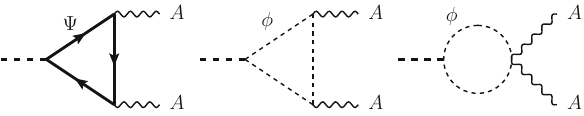
Fig. 2 One-loop diagrams contributing to the Wilson coefficients C AA and (cid:4) C AA in (1). We do not show crossed graphs, in which the two boson lines are exchanged. Loops graphs involving SM fermions do not arise at leading order in λ